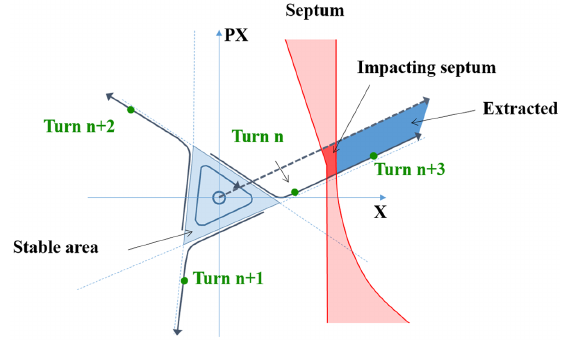
FIG. 2. Spread in particle positions caused by scattering at a diffuser upstream of the ES, after a suitable phase